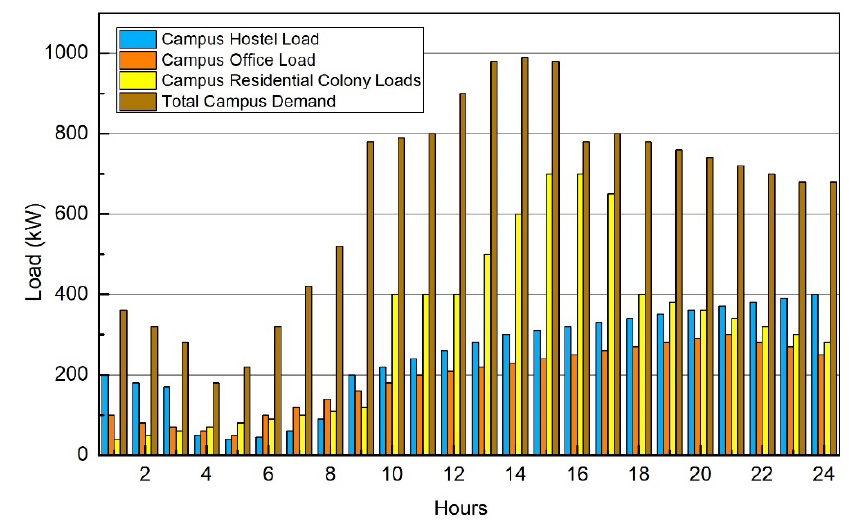
Figure 5. Average campus load demand among buildings.